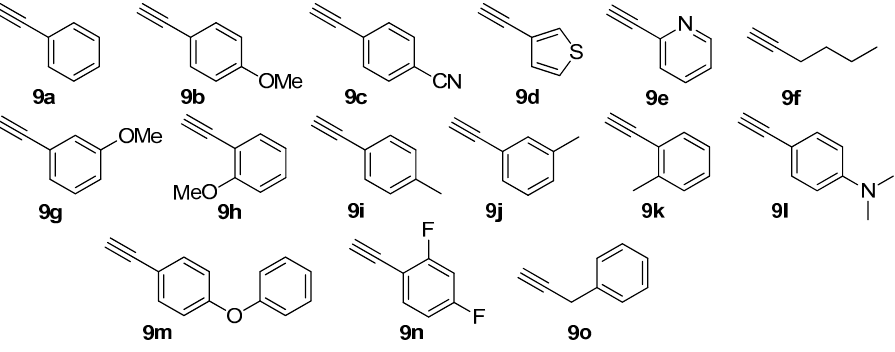
Figure 4. Diversity reagents 9 for 1,2,3-triazoloamides 1 and 2 .